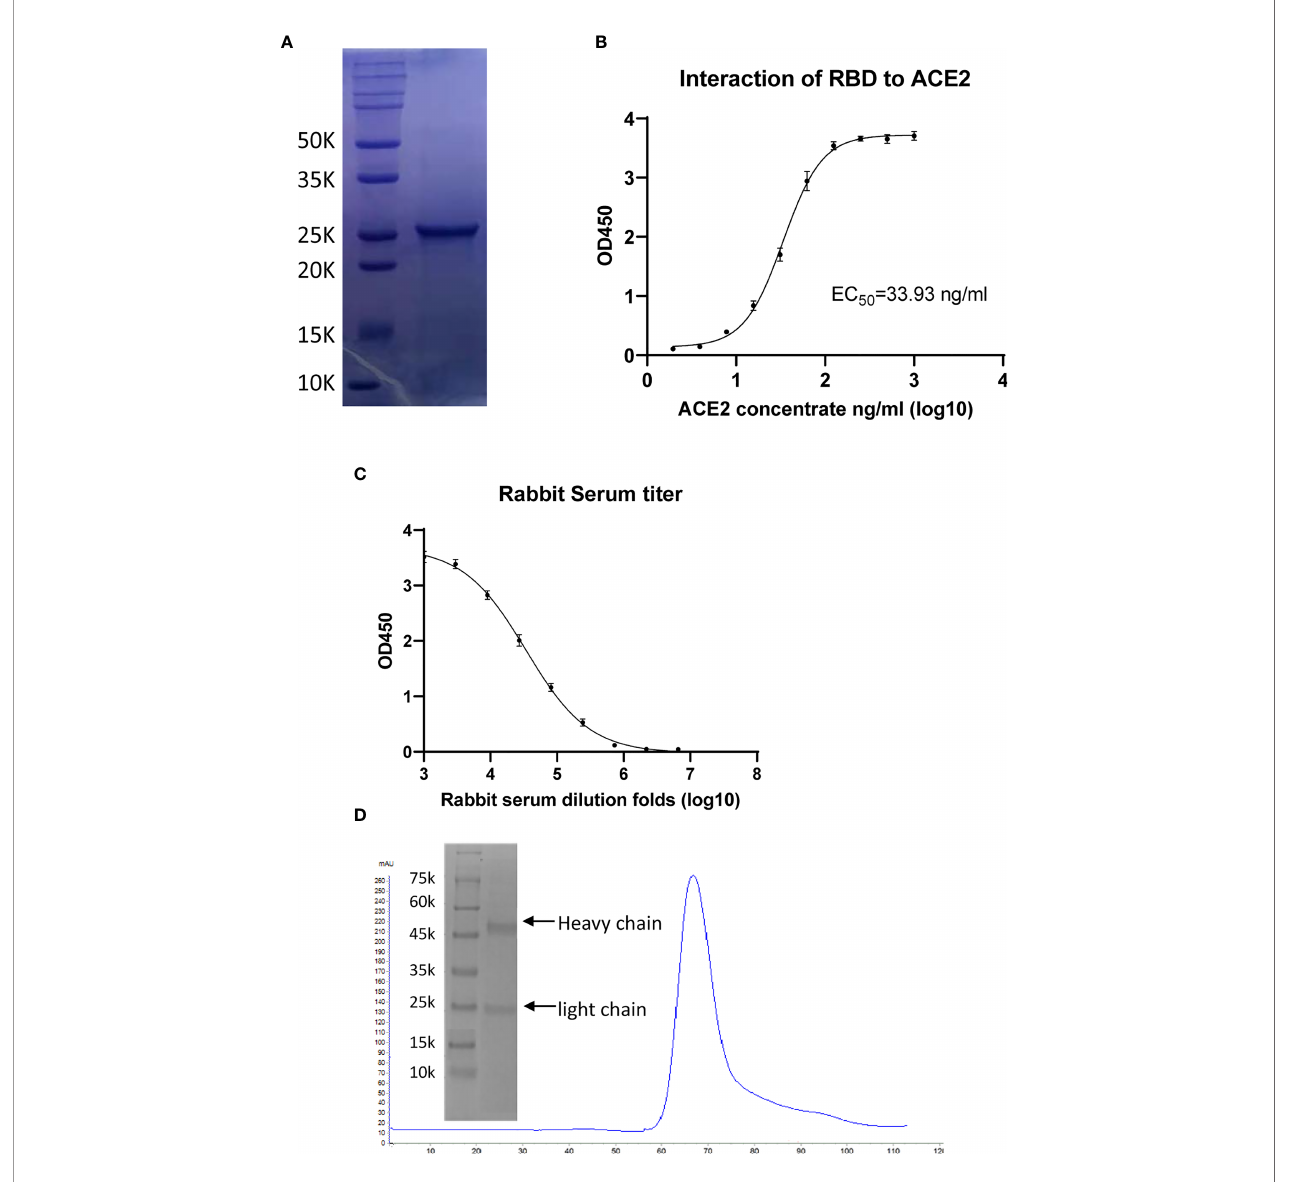
FIGURE 2 | Characterization of receptor-binding domain (RBD) protein antigen and the generated polyclonal antibodies (pAbs). (A) Sodium dodecyl sulfate – polyacrylamide gel electrophoresis (SDS-PAGE) of puri fi ed RBD protein having a molecular weight (MW) of approximately 26 kDa. (B) ELISA of the binding of angiotensin-converting enzyme 2 (ACE2) to immobilized RBD, giving an EC 50 value of 33.93 ng/ml. (C) ELISAs checking the antibody titers of rabbit serum before and after immunization. (D) Puri fi cation of anti-RBD pAbs through protein-A af fi nity and detection through